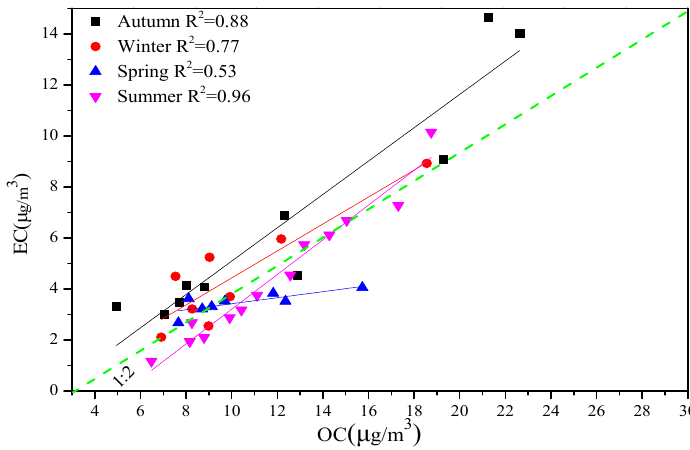
Figure 5. Correlation between OC and EC.